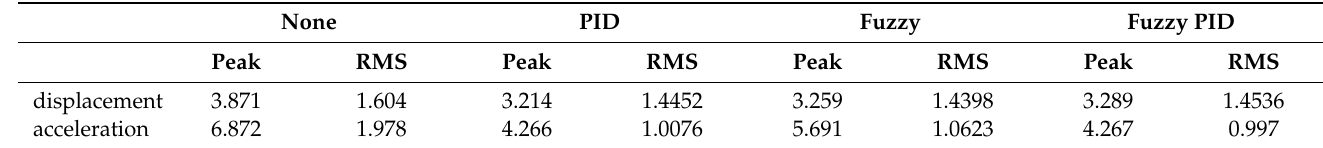
Figure 16. MRE vibration isolator response signal: ( a ) acceleration and ( b ) displacement;. Table 2. Response of the vibration isolators under vibration